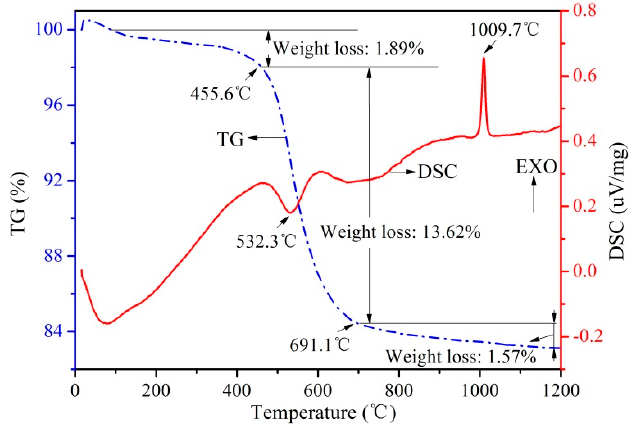
Figure 5. TG and DSC analysis of raw coal gangue under air flow.